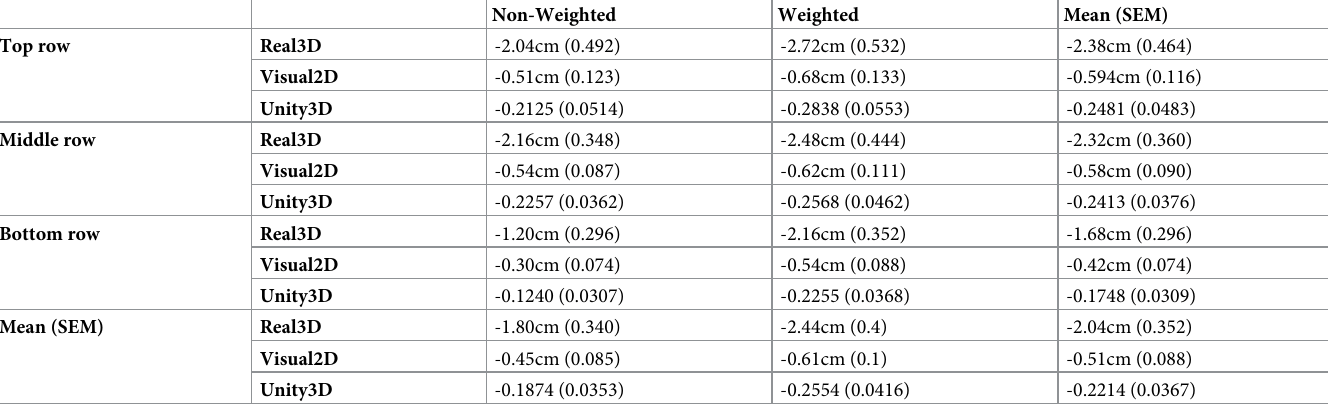
Table 1. Mean reaching frequency midline positions and standard errors of the mean (SEM).